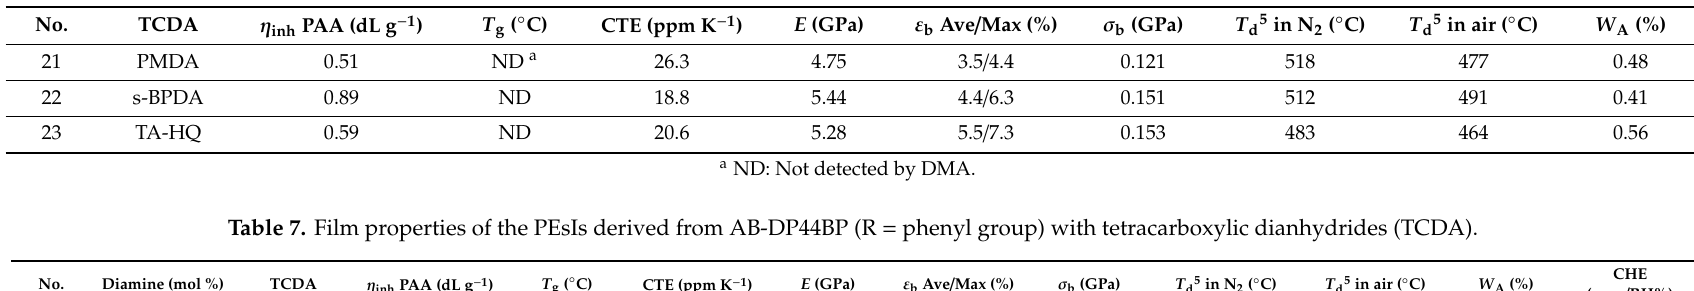
Table 6. Film properties of the PEsIs derived from AB-44BP with tetracarboxylic dianhydrides (TCDA).